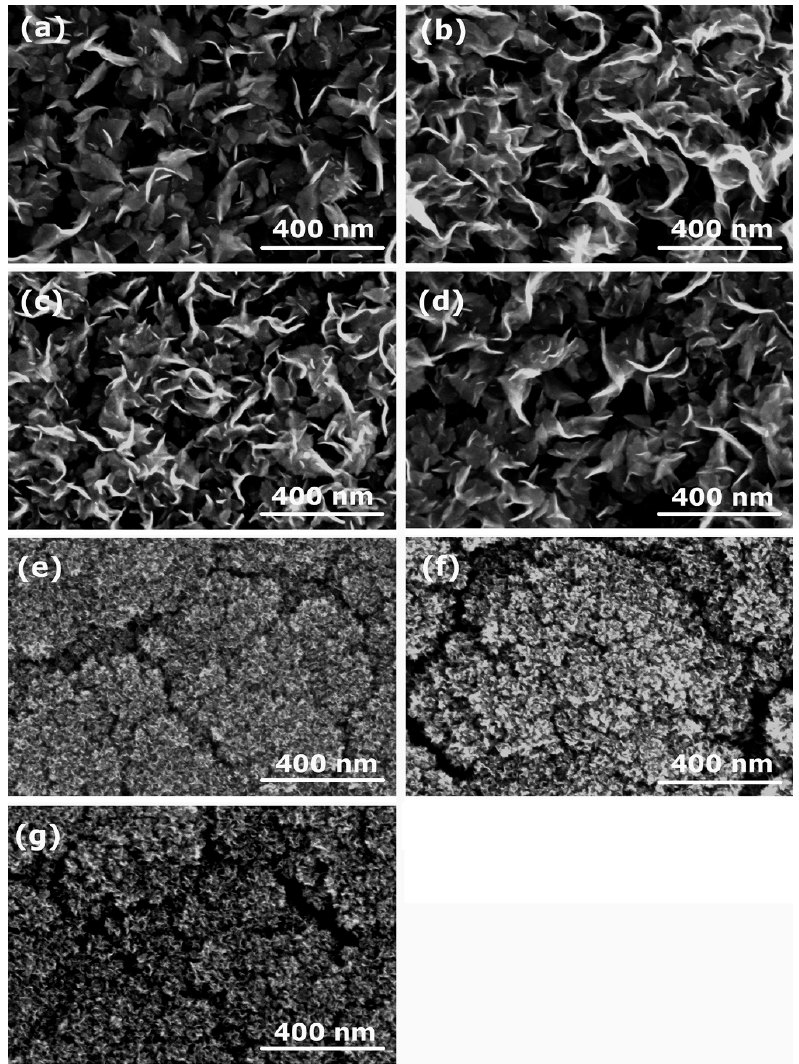
Figure 4. SEM images of carbon nanostructures synthesized from various polymers: ( a ) PP, ( b ) PA6, ( c ) LDPE, ( d ) HDPE, ( e ) PET, ( f ) PS, and ( g ) ABS. Deposition time in nitrogen plasma was 60 s.